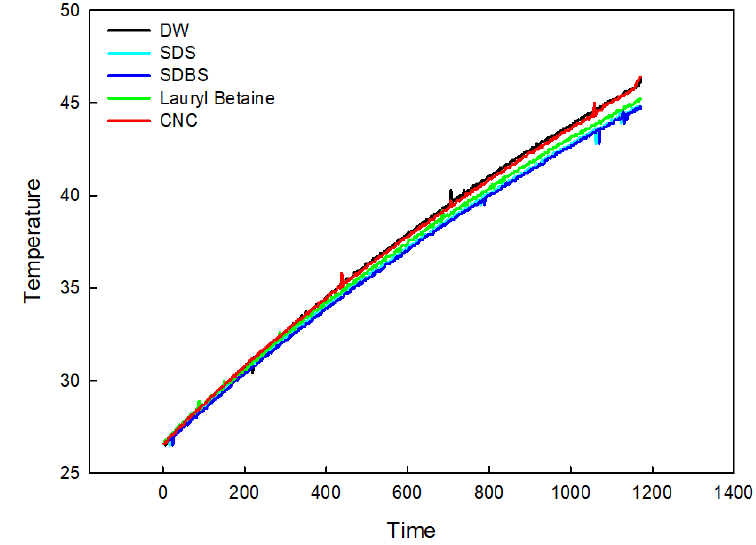
Figure 9. The comparison of heat capacity of various surfactants.